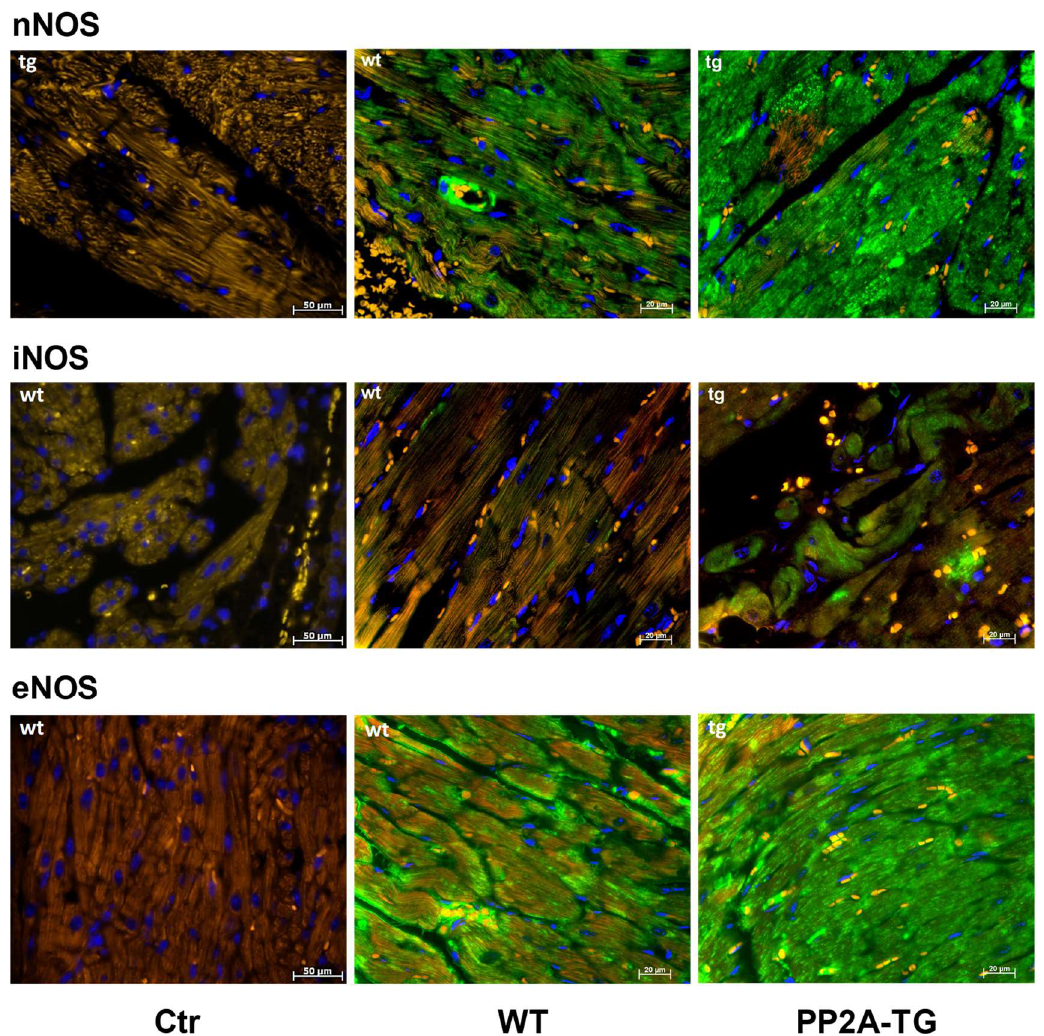
Figure 8. Immunohistochemical detection of NOS1 (nNOS), NOS2 (iNOS), and NOS3 (eNOS) in ventricular tissue sections from wild type (WT) and PP2A transgenic mice (TG). Controls (Ctr) are samples with omission of the first antibody. Bars in the lower right angle of the photographs indicate the length markers in micrometers (µm). Nitric oxide synthase (NOS) isoforms are stained in green. Nuclei are counterstained in blue with DAPI (4′,6-diamidino-2-phenylindole). Red blood cells appear yellow colored due to autofluorescence. Note the differences in NOS expression between WT and TG. This set of hearts is representative of two other experiments.